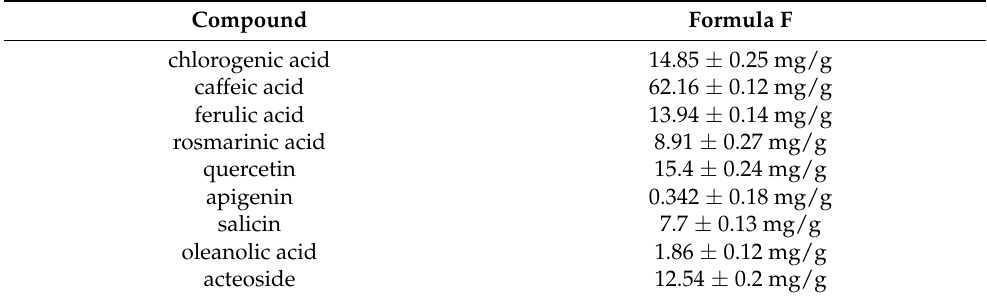
Table 2. The content of compounds of interest of formula determined by